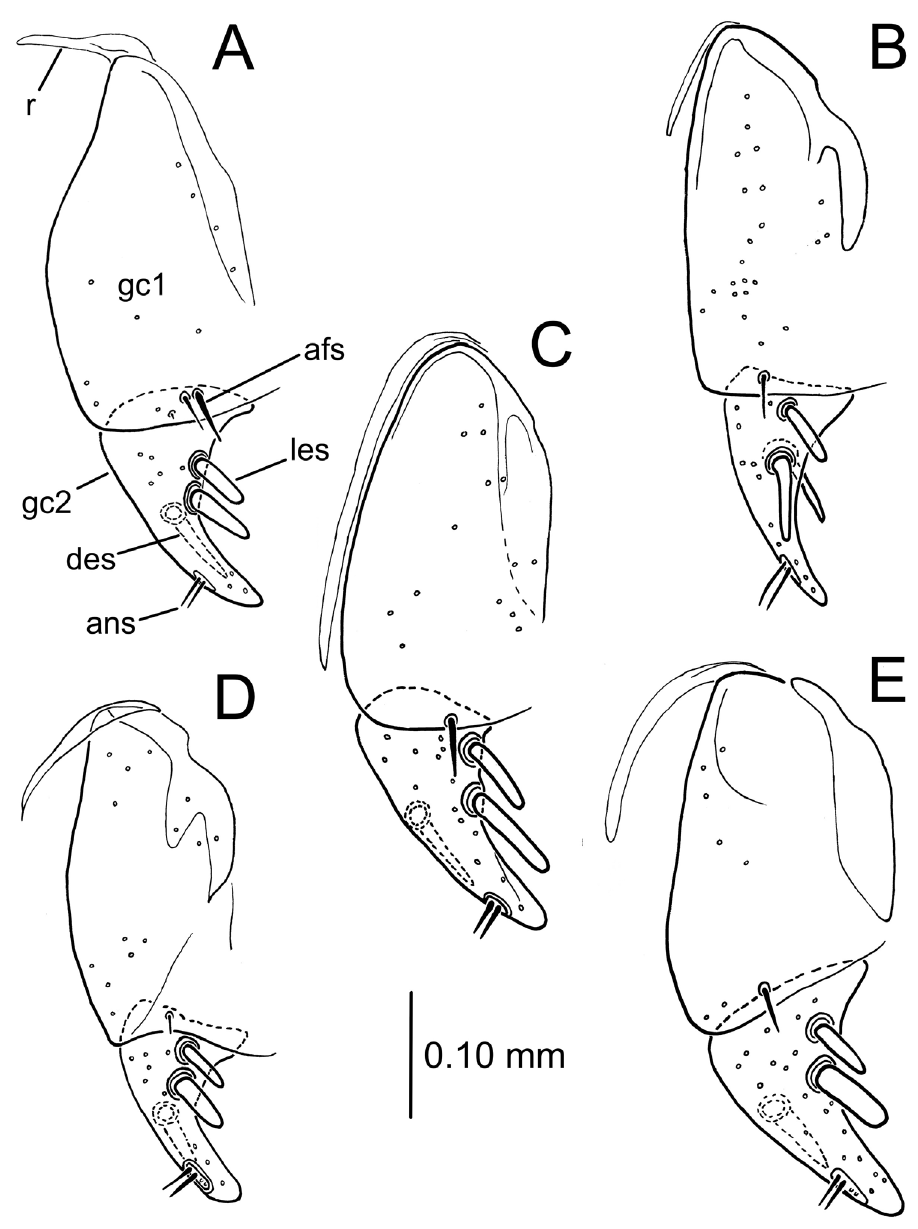
Figure 8. Left gonocoxa, ventral view of Theprisa spp., ventral view A T. otway B T. convexa C T. mon- tana D T. australis E T. darlingtoni . Abbreviations: afs, apical fringe seta(e) of gonocoxite 1; ans, apical nematiform setae; des, dorsal ensiform seta; gc1, basal gonocoxite 1; gc2, apical gonocoxite 2; les, lateral ensiform setae; r,